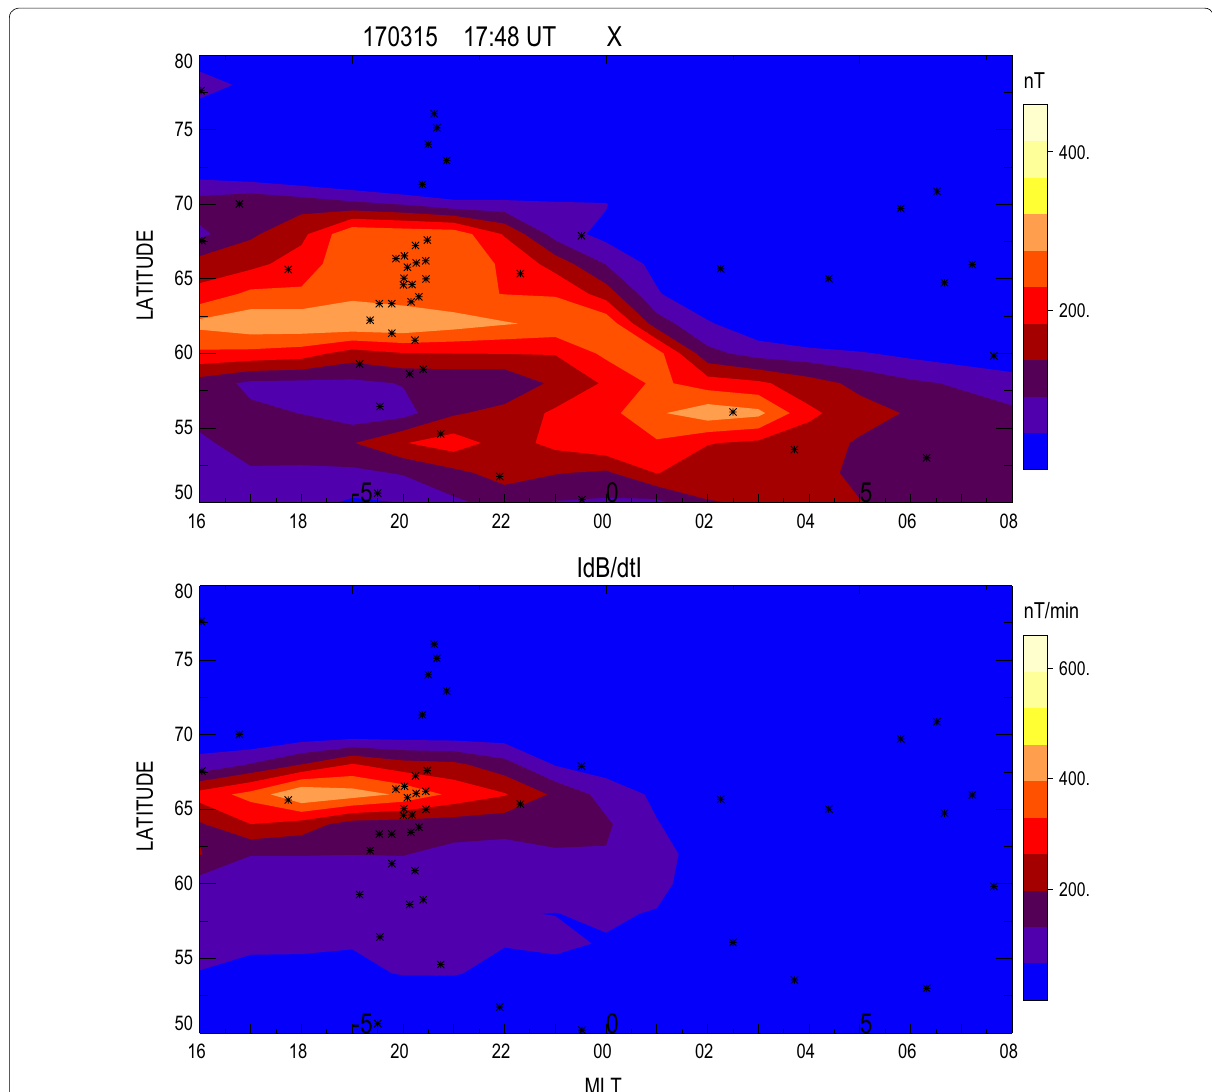
Fig. 4 Global Φ -LT maps for the time moment 1748 UT (substorm #4) of the Δ X variations (upper panel) and magnetic variability |d B /d t | (bottom panel). Small black crosses denote the station location. No OVATION model data are available for this